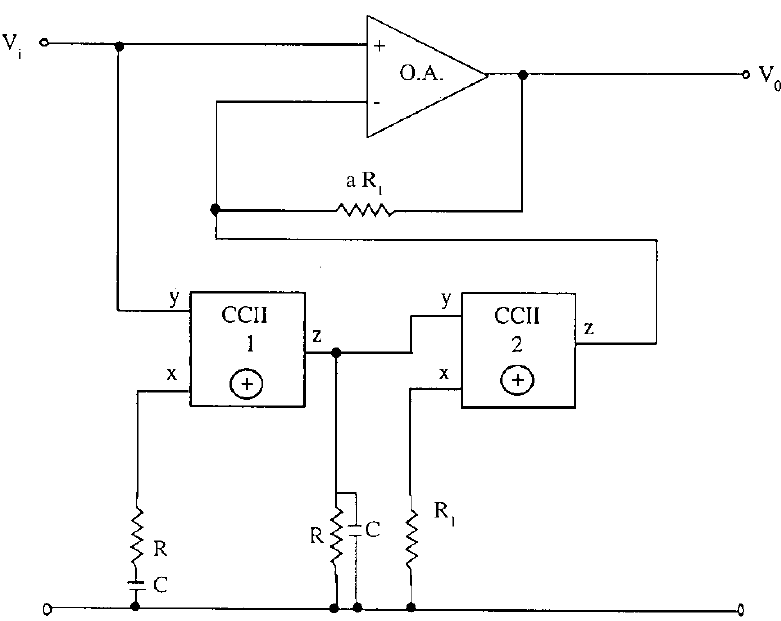
FIGURE 3 Another novel second-order all-pass = notch